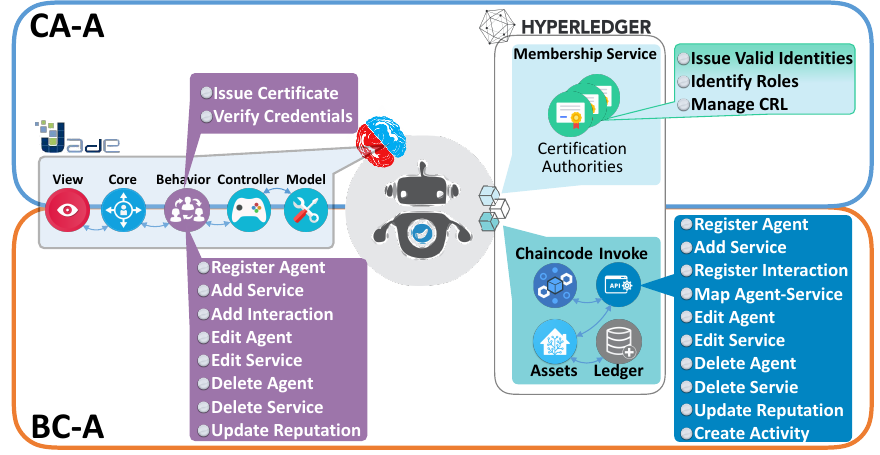
Figure 1. Conceptual design of the system components